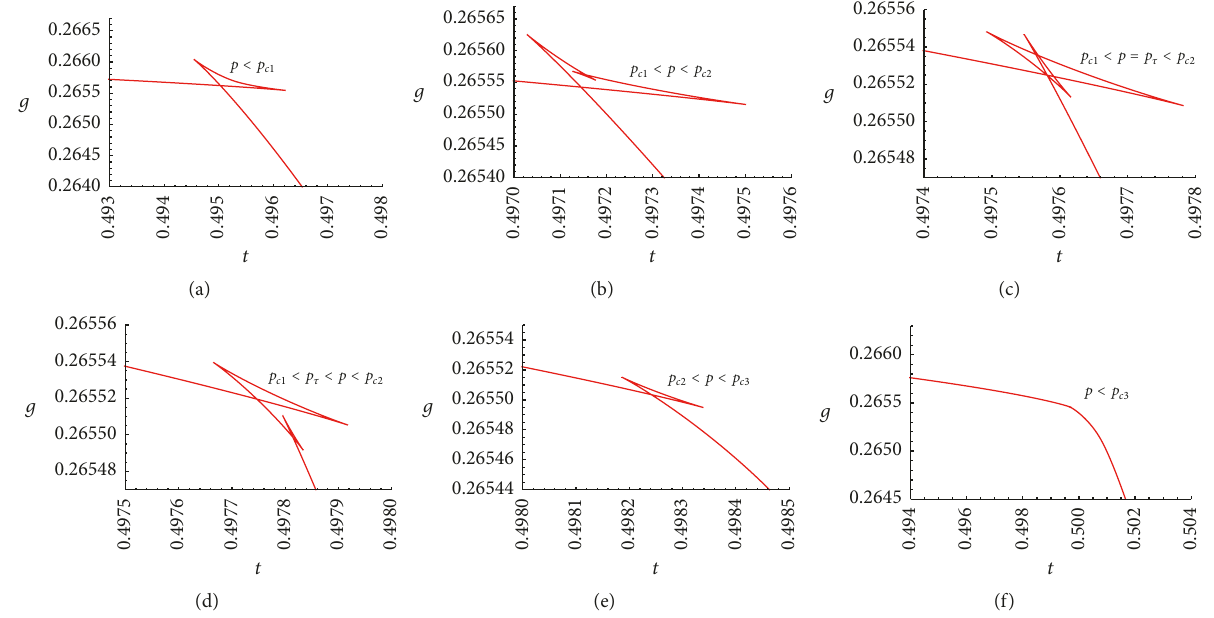
Figure 8: Gibbs free energy of five-dimensional AdS black holes for 𝑤 2 = −0.084825 and 𝑤 3 = −0.045